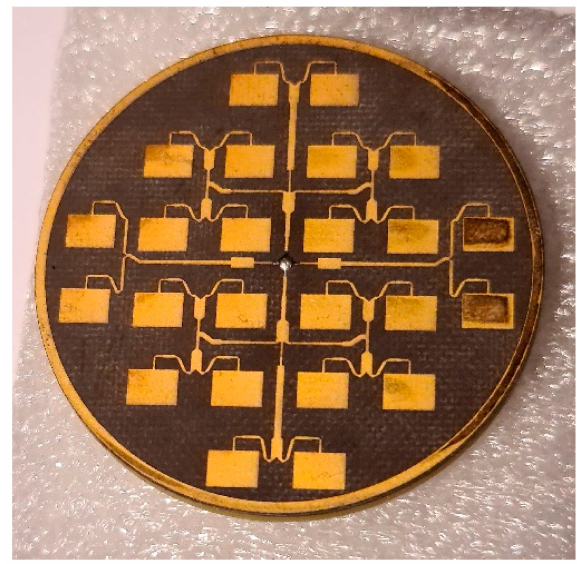
Figure 23. Microstrip antenna array with 24 elements.